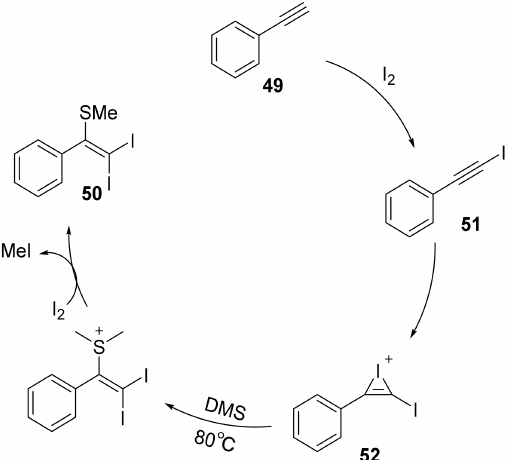
Scheme 14. Reaction mechanism of selective iodized